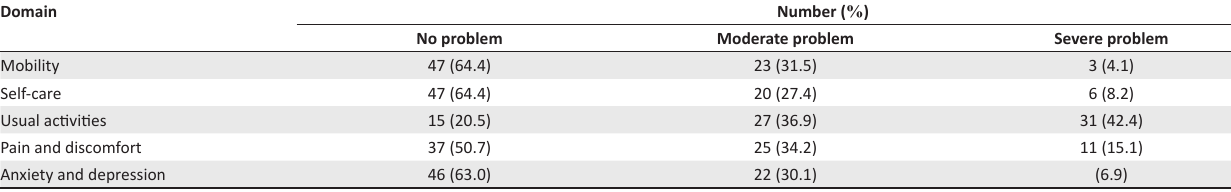
TABLE 2: EQ-5D results at six months post stroke ( n = 73).